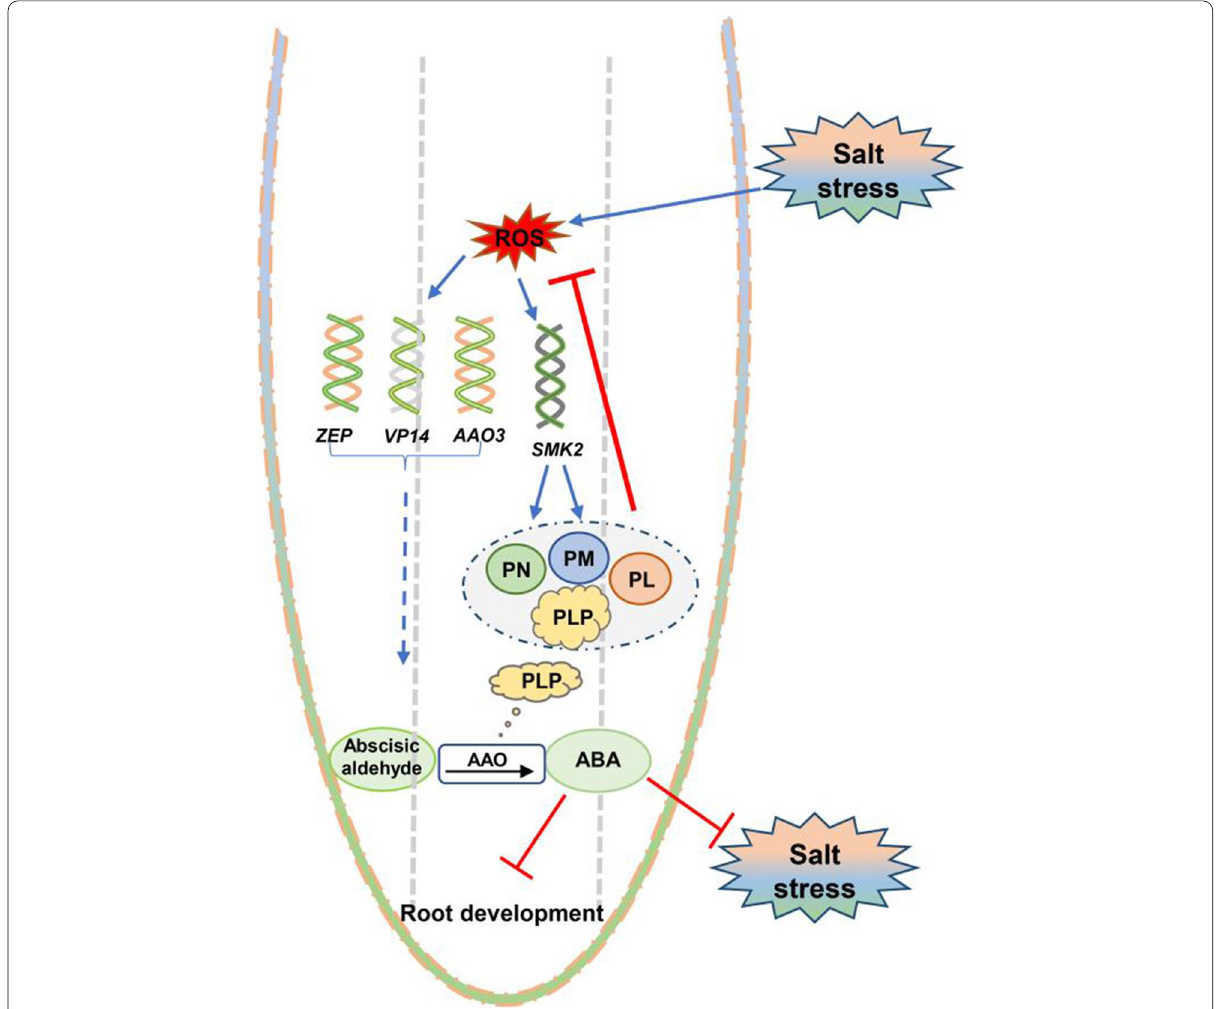
Fig. 7 Possible model of VB6 involved in the plant response to salt stress. On the one hand, salt stress-induced ROS accumulation leads to oxidative damage and root inhibition, which further induces the expression of ZEP , AAO3 and VP14 and upregulates the VB 6 (PL, PN, PM, PLP) content in maize roots. As a feedback mechanism, PN could scavenge excessive ROS to reduce the damage of oxidative stress to maize roots. On the other hand, PLP promoted AAO activity, further improving ABA production to inhibit root development and enhance plant salt stress